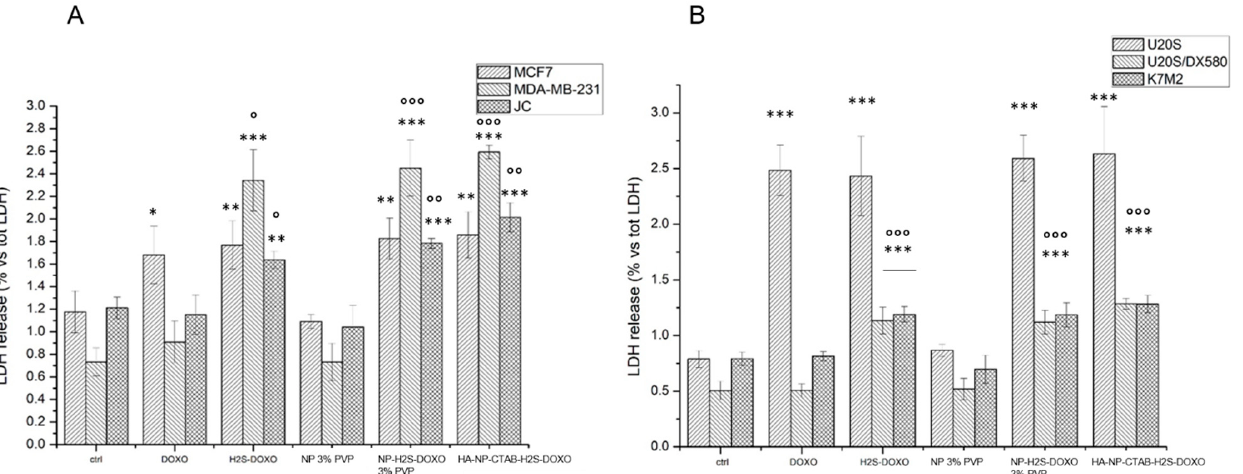
Figure 9. Acute cytotoxicity in: ( A ). breast cancer cells; ( B ). osteosarcoma cells. Cells were incubated 24 h with 5 µM with free DOXO, free H 2 S-DOXO, NP-H 2 S-DOXO 3% PVP, and HA-NP-CTAB-H 2 S- DOXO (containing 5 µM H 2 S-DOXO), then the release of LDH was measured spectrophotometrically (n = 3). Data are means + SD. * p < 0.05, ** p < 0.01, *** p < 0.001: versus ctrl; ° p < 0.05, °° p < 0.01, °°° p < 0.001: versus DOXO .